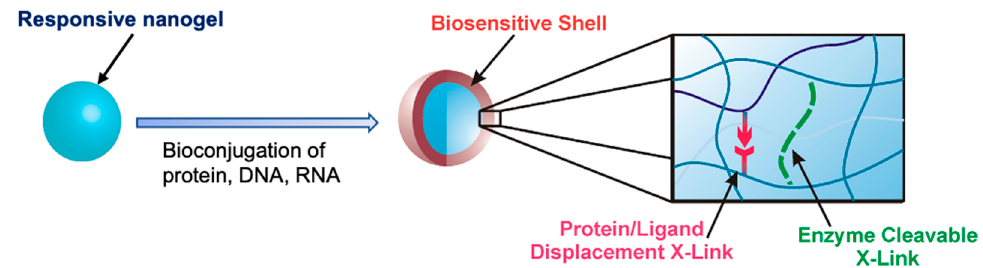
Figure 8. Schematic of a bioresponsive nanogel prepared by conjugating protein, DNA, and RNA to a responsive nanogel.